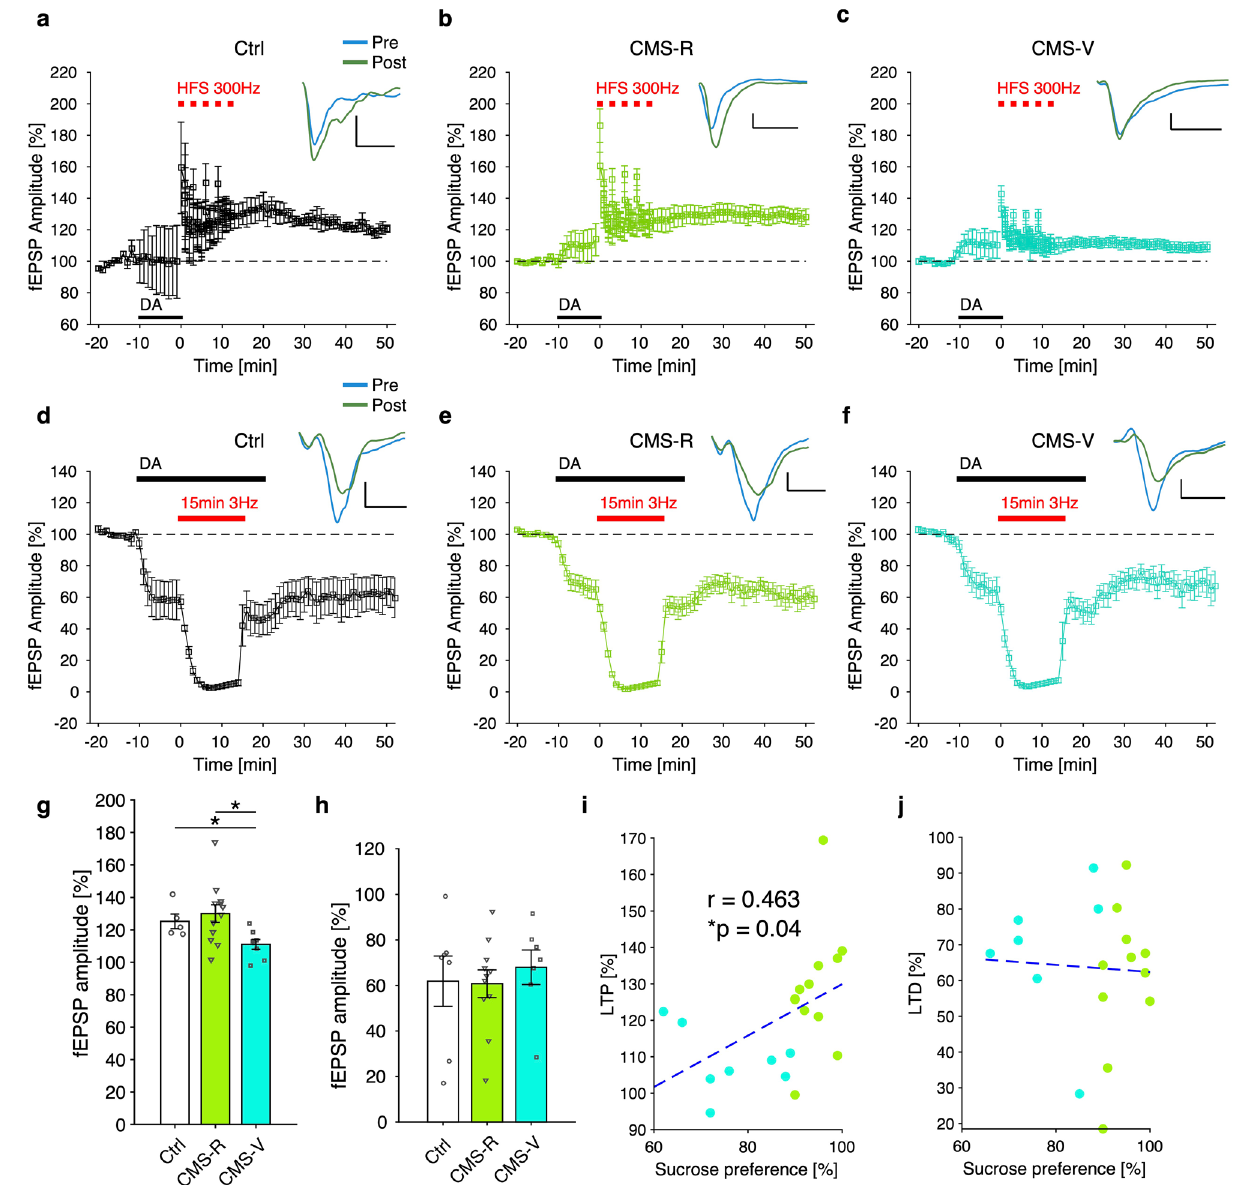
Figure 2. DA-LTP is occluded in CMS-vulnerable rats while DA-LTD is unaffected. ( a – c ) Time course of DA-LTP experiments in mPFC slices coming from control ( a ), CMS-R ( b ) and CMS-V rats ( c ); representative fEPSP responses before (blue) and after (green) LTP induction are shown on top of each graph (scale bar: 20 ms × 0.2 mV). ( d , e ) Time course of DA-LTD experiments in mPFC slices coming from control ( d ), CMS-R ( e ) and CMS-V rats ( f ); representative fEPSP responses before (blue) and after (green) LTD are shown on top (scale bar: 20 ms × 0.2 mV). ( g , h) Analysis of population data shows significant effect of group for DA-LTP induction (n: Ctrl/CMS-R/CMS-V = 5/12/8 slices from 5/12/8 rats; K–W test, p = 0.019; permutation tests, B–H correction: CMS-R vs. Ctrl, n.s.; CMS-V vs. Ctrl, p = 0.036; CMS-V vs. CMS-R, p = 0.034) ( g ), while lack of effect for DA-LTD experiments (n: Ctrl/CMS-R/CMS-V = 7/11/7 slices from 7/11/7 rats; K–W test, n.s.; permutation tests, B–H correction: no comparison resulted significant) ( h ). ( I , j ) Final fEPSPs amplitude resulted correlated to sucrose preference after DA-LTP (Pearson’s correlation: r = 0.463; p = 0.04) ( i ), but not after DA-LTD (Pearson’s correlation: r = − 0.051; n.s.; dashed blue lines represents 2 parameters linear fitting) ( j ). DA dopamine, HFS high-frequency